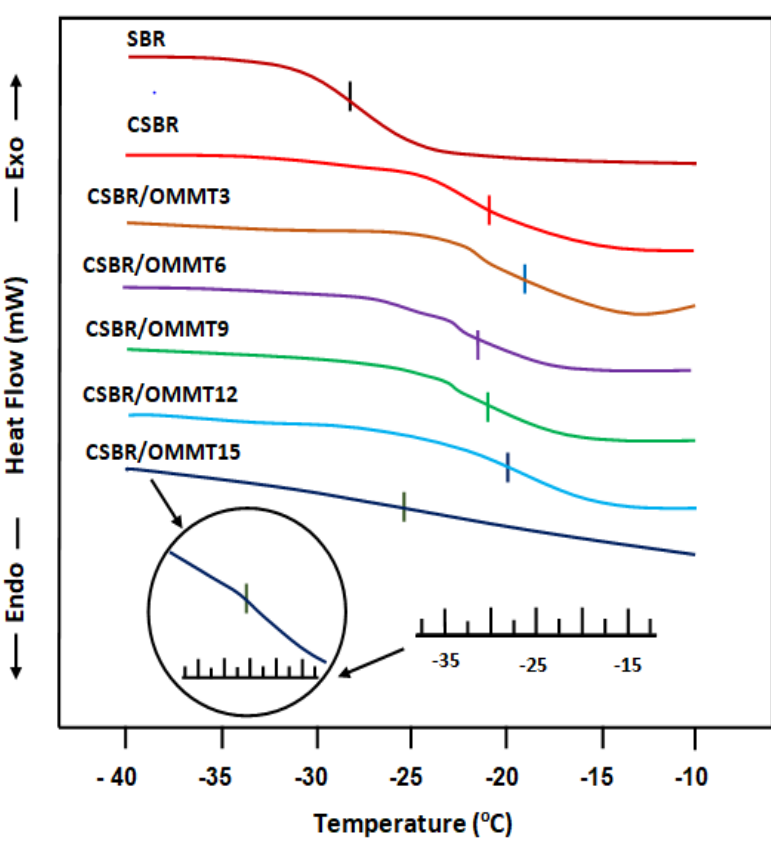
Figure 5. DSC thermograms of pure SBR, CSBR and CSBR/OMMT